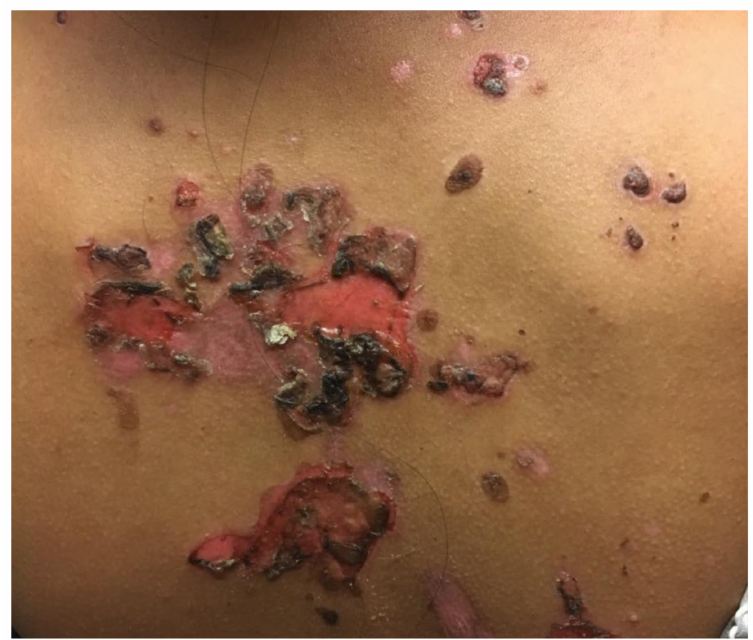
Figure 1. Pemphigus vulgaris. Flaccid bullae and crusted erosions on the back.